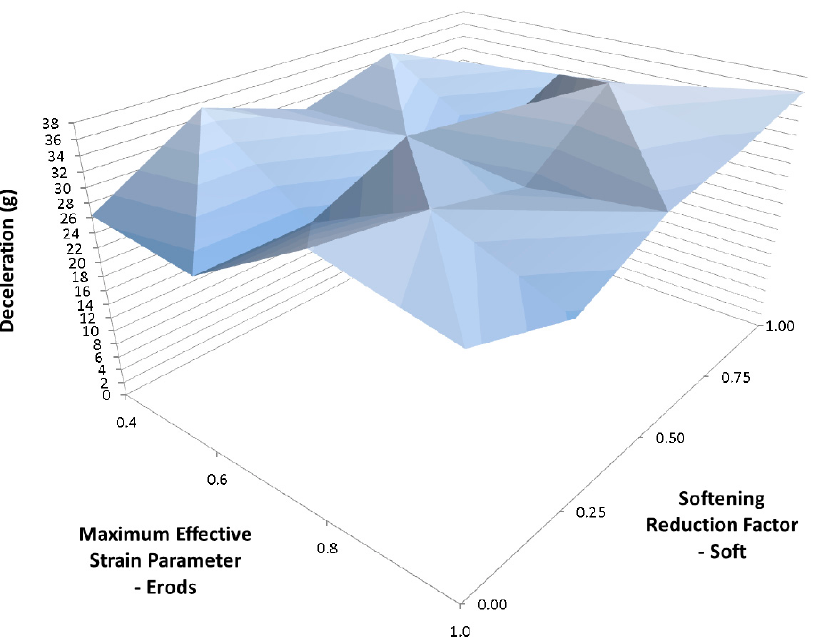
Figure 20. Effect of Erods parameter and Soft factor with Slim T = 0.6, Slim C = 1.0, Slim S = 1.0, TSize = 1 × 10 − 11 and FS = − 1.0.